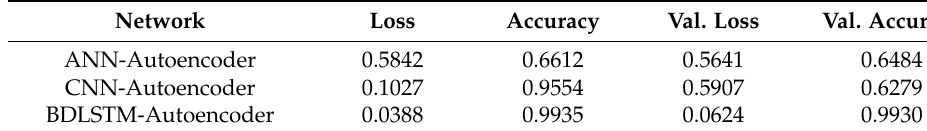
Table 3. Results of tests using the ISCXIDS2012 dataset for three models.